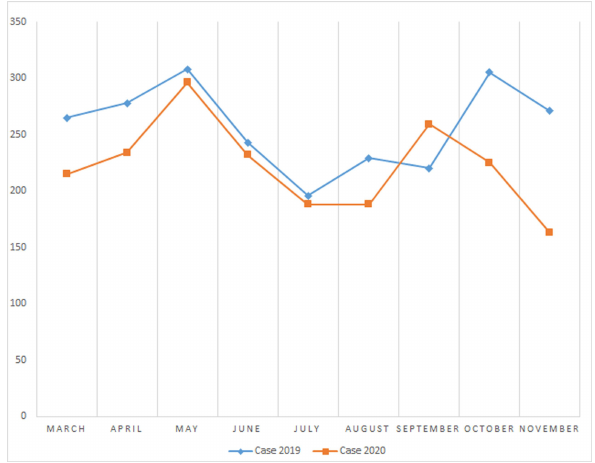
Figure 1: Monthly noise complaints comparison of before the COVID- 19 and during the